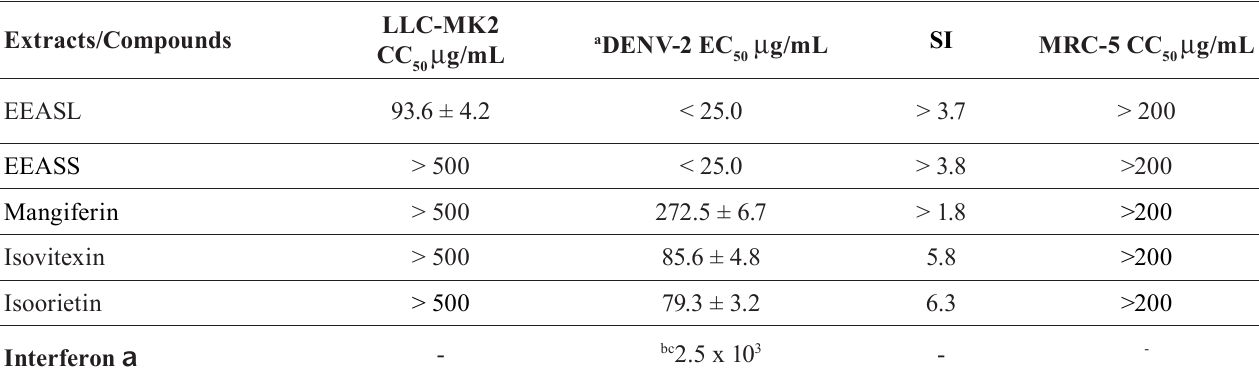
, LLC-MK2 and MRC-5 cells), in vitro antiviral activity (EC 50